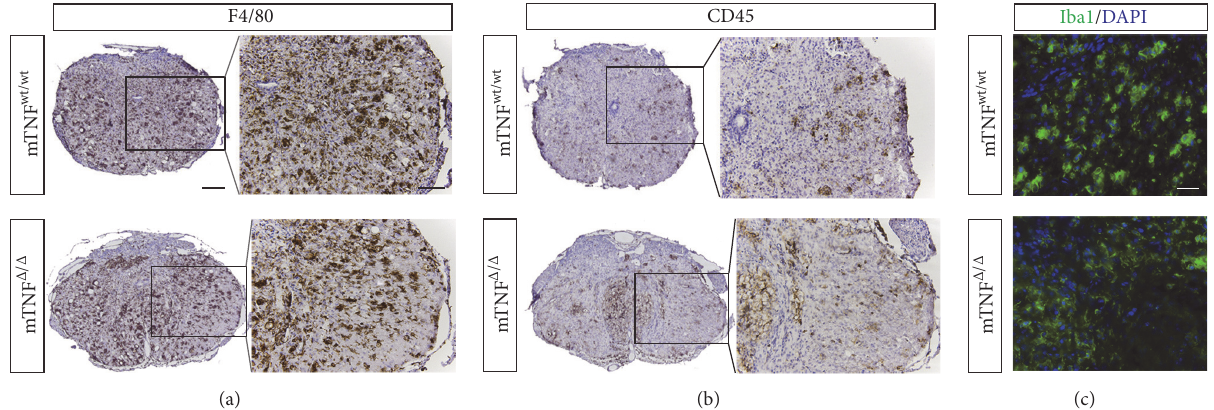
Figure 6: Microglial and leukocyte immunoreactivity 35 days after SCI. (a–c) Immunohistochemical staining for F4/80 (a) and CD45 (b) and immunofluorescent staining for Iba1 (c) were comparable between mTNF wt / wt and mTNF Δ/Δ mice 35 days after SCI. Analysis was based on 5 sections from each animal, 𝑛 = 4 mice/group. Scale bars: (a, b) low magnification = 200 𝜇 m and high magnification = 100 𝜇 m. (c) 40 𝜇